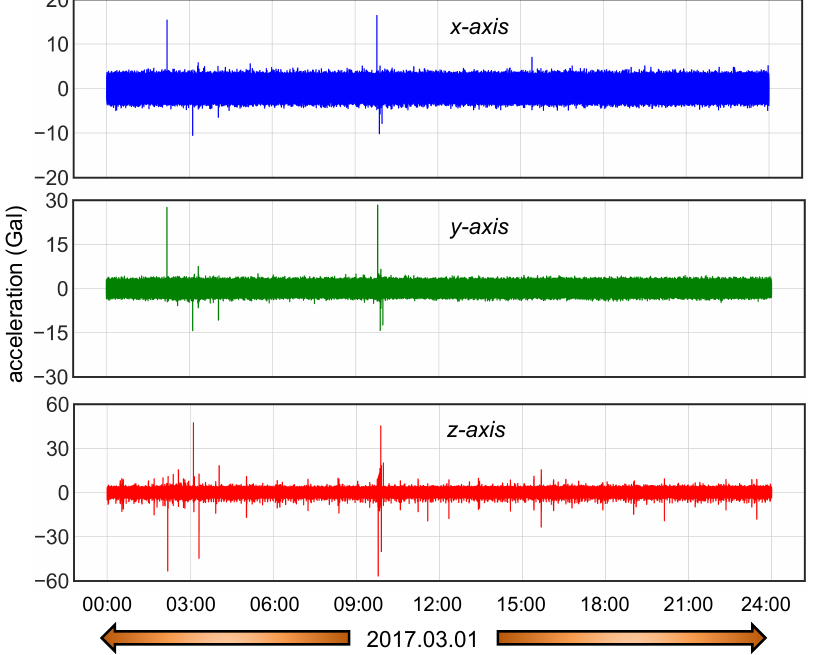
Figure 18. Smartphone measured field acceleration for 24